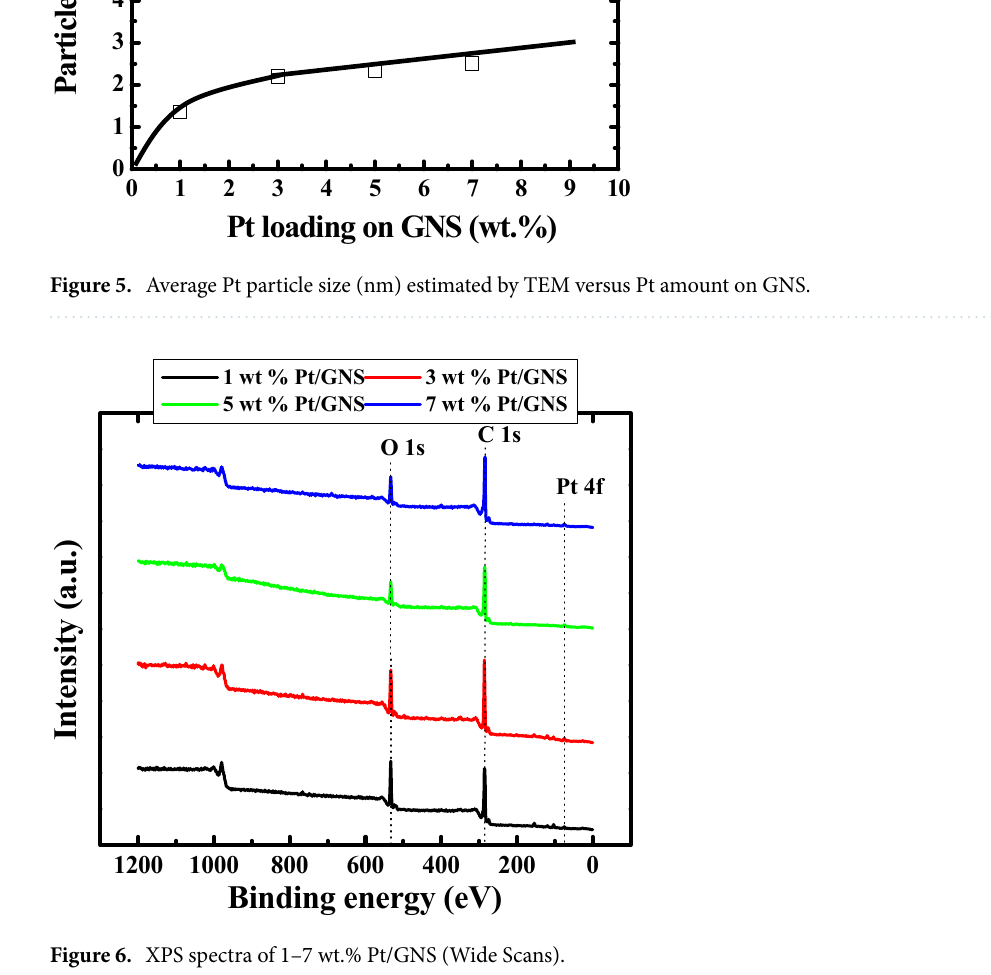
Figure 6. XPS spectra of 1–7 wt.% Pt/GNS (Wide Scans).